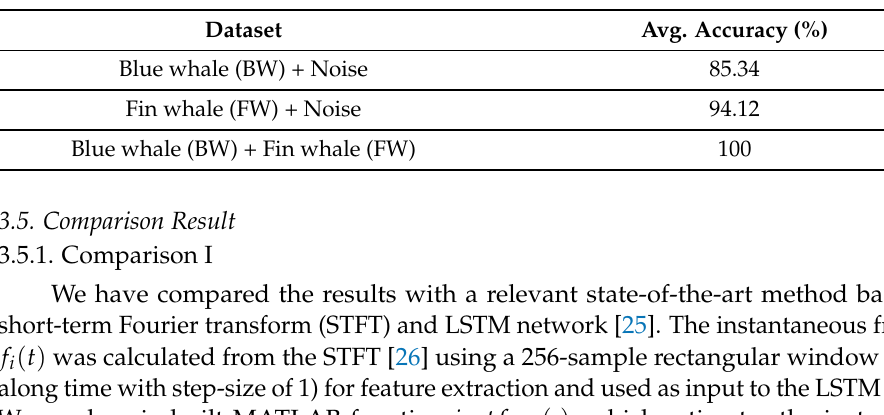
Table 5. The average accuracies (%) obtained by using the SVM